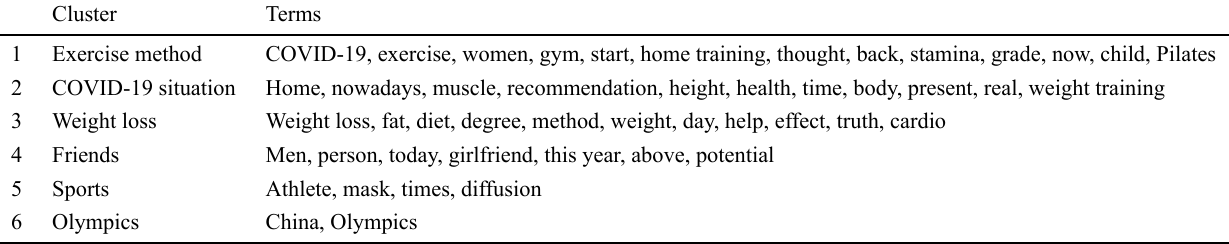
Fig. 3. Women’s exercise CONCOR analysis results. Red cluster = exercise method; orange cluster = COVID-19 situation; brown cluster = weight loss; yellow cluster = friends; green cluster = sports; violet cluster = Olympics; black = could not form a cluster. Table 7. Results of the women’s exercise CONCOR